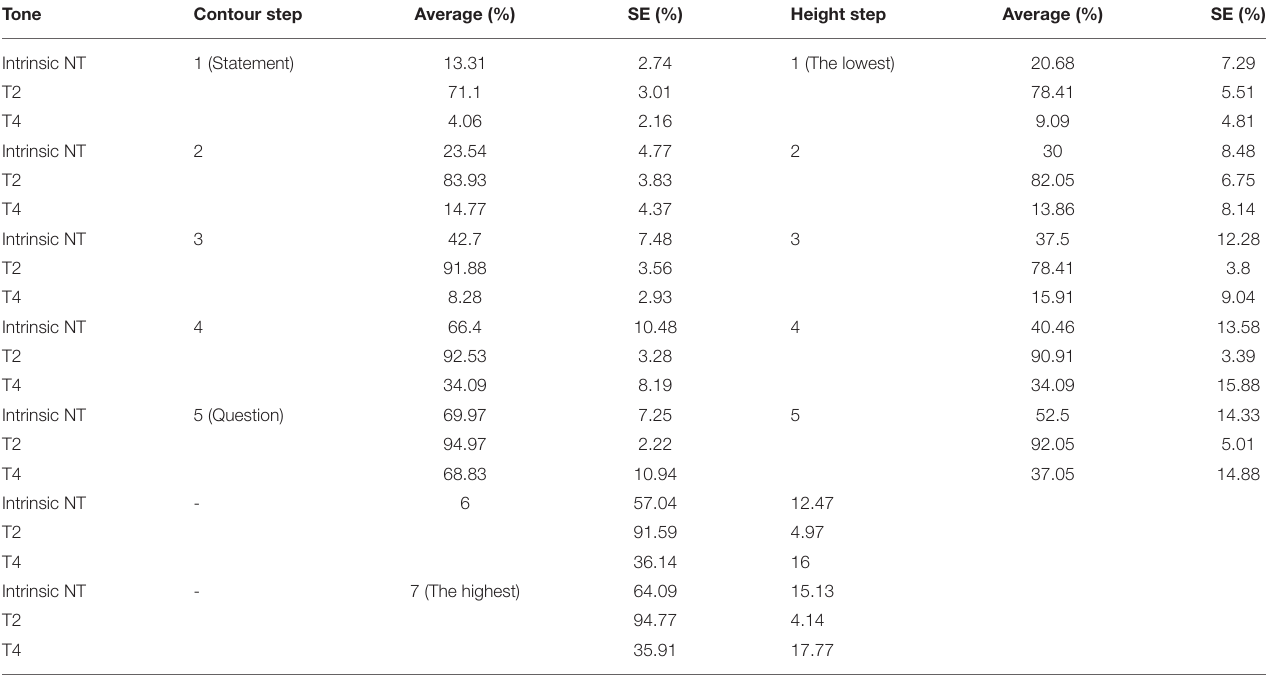
TABLE 6 | Percentage of stimuli identified as question, by contour steps and height steps.